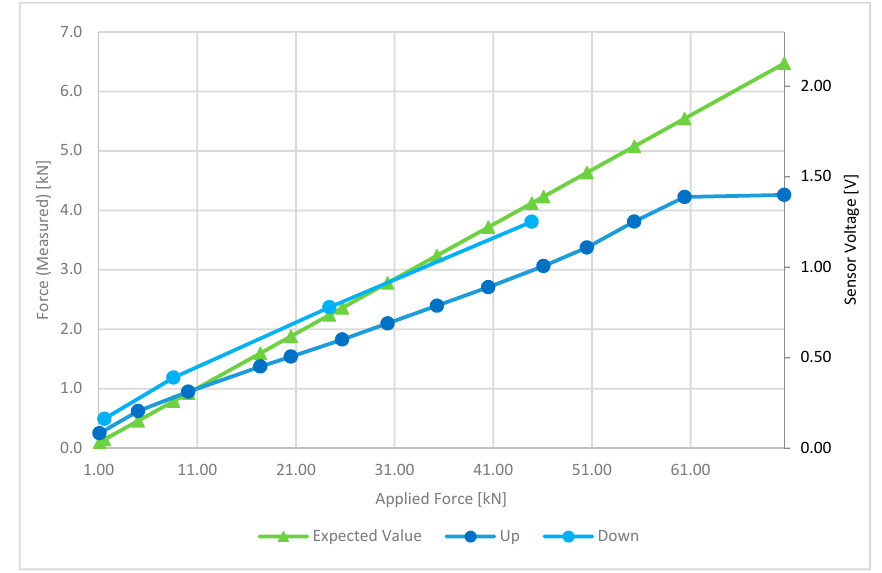
Figure 19. Load cell analysis of the embedded system during load and unloading phases.